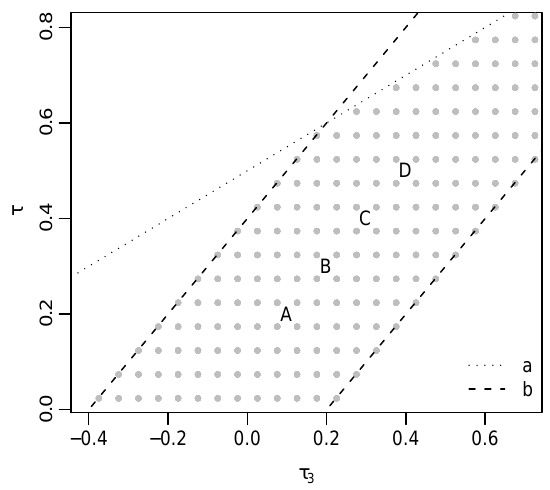
Fig. 1. L-CV–L-CA diagram. Lines are: (a) numerical constraint given by Hosking and Wallis (1997); (b) bisector band identified using Vogel and Wilson (1996) samples (see Viglione et al., 2007). Points A, B, C and D have L-CV τ =0.2, 0.3, 0.4, 0.5 and L-CA τ 3 =0.1, 0.2, 0.3, 0.4,